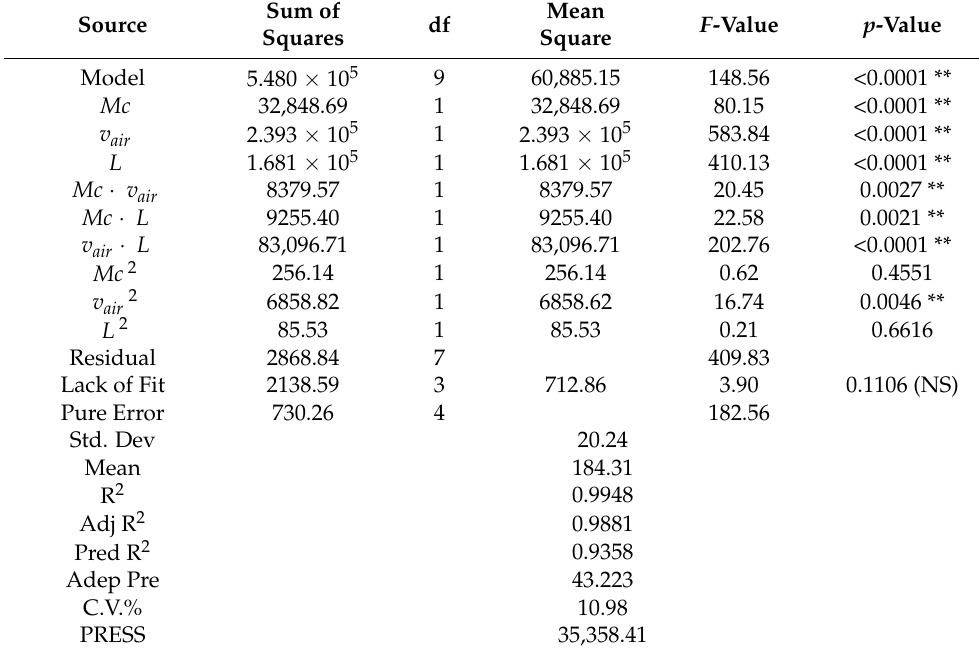
Table 5. ANOVA evaluation of linear, quadratic, and interaction terms for response and coefficient of ∆ p